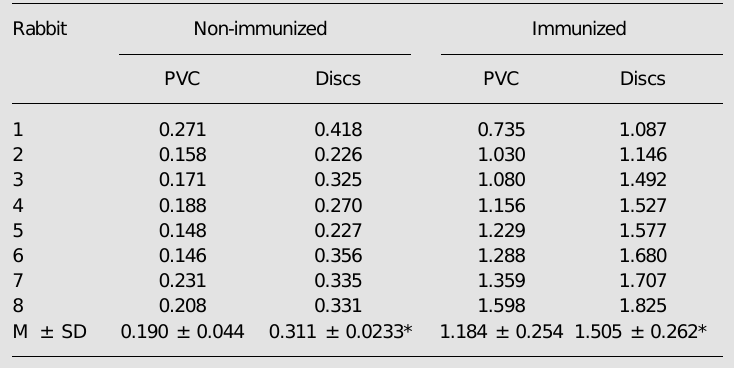
Table 1. Comparison of ELISA using polysiloxane/polyvinyl alcohol-glutaraldehyde discs and polyvinyl chloride (PVC) as solid phases.